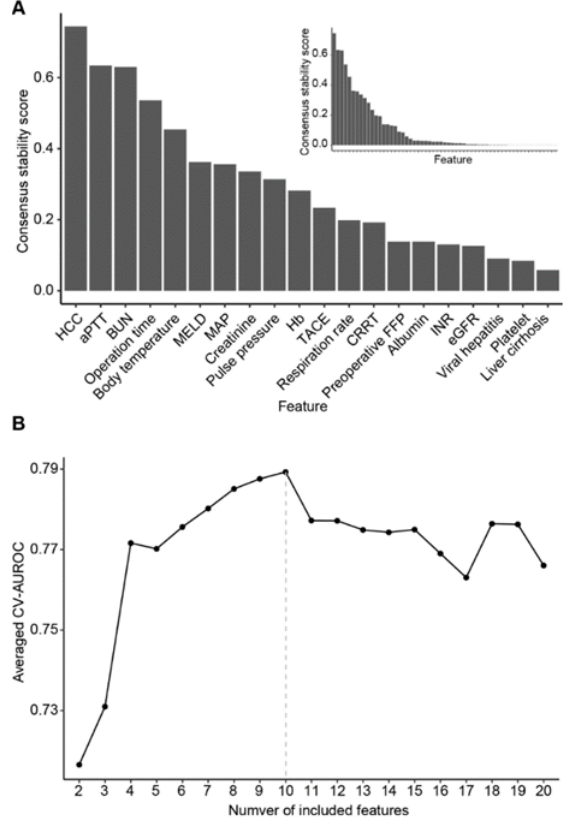
Figure 2. Feature selection results. ( A ) Features ordered according to consensus stability scores averaged across the outer CV folds (Methods). Outset: The top 20 features are shown. Selected features based on the optimal number of features are in bold. Inset: The overall distribution of the stability scores of all of the features is shown. ( B ) Averaged CV-AUROC with the incremental numbers of the features. The grey vertical line indicates the optimal number of features.